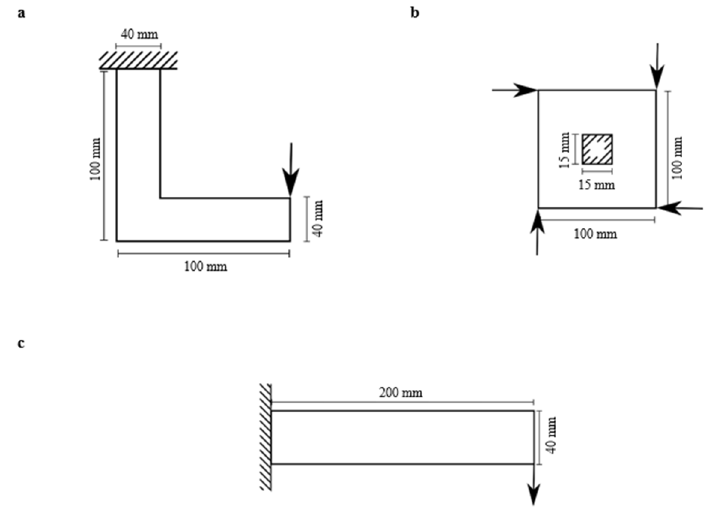
Figure 10. These examples will be used to investigate the influence of the optimization algorithm for different geometries. Example ( a ) is an L-bracket, ( b ) shows the square design domain with a central square rigid support [22] and ( c ) a cantilever beam with an aspect ratio of 5.